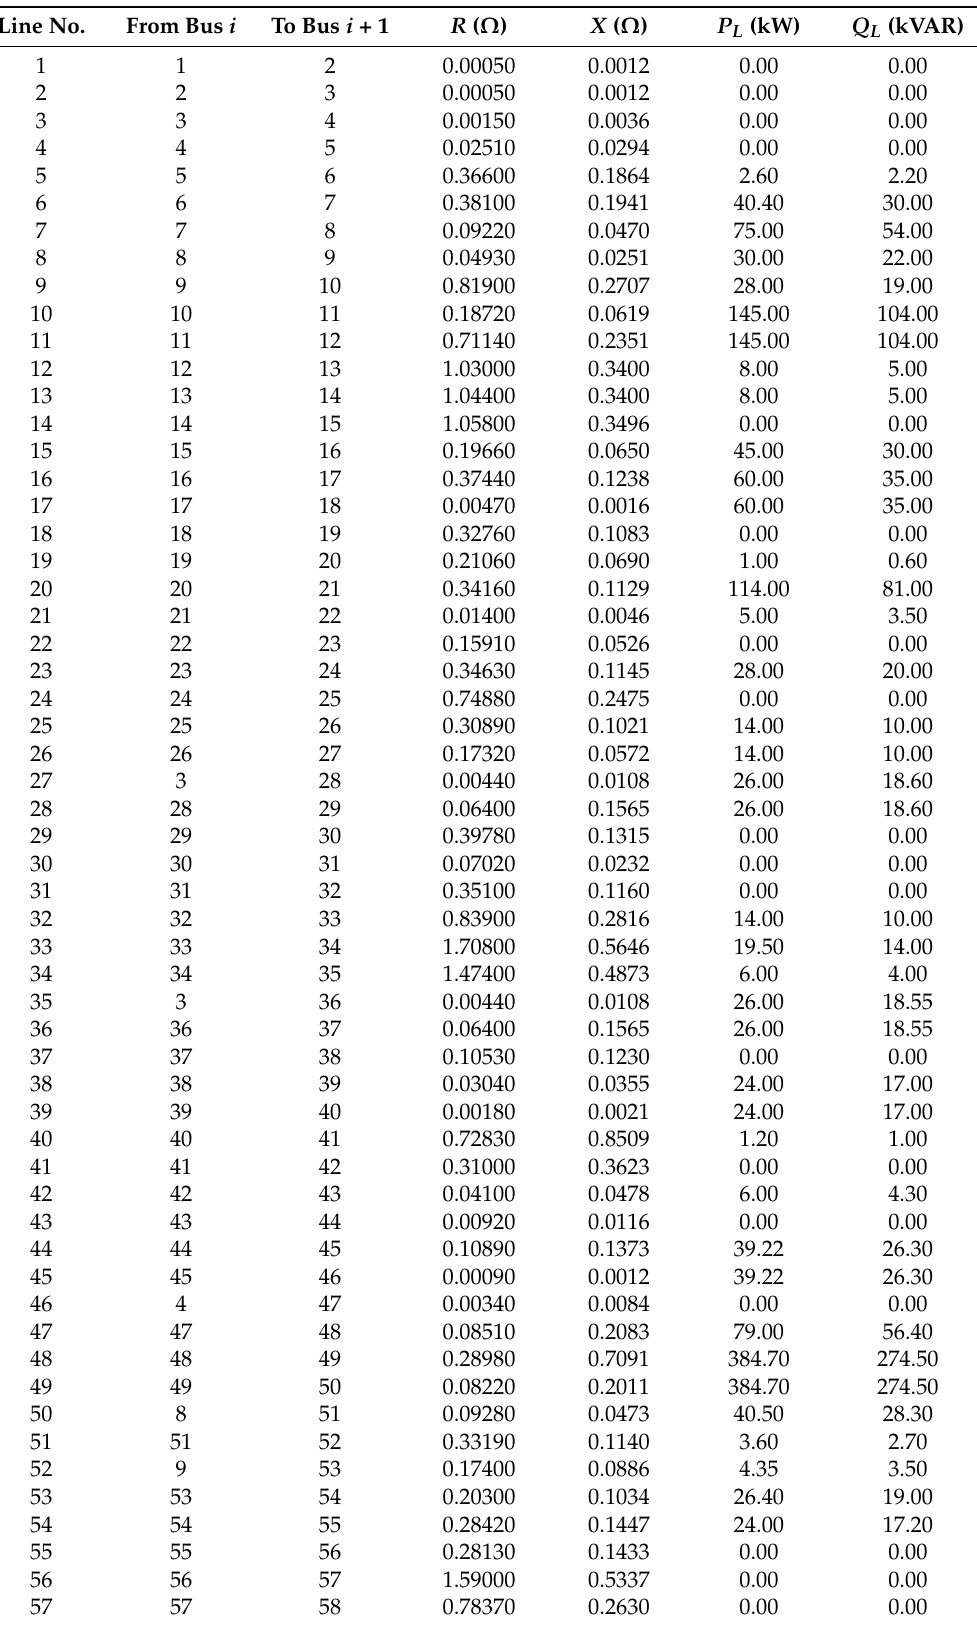
Table A3. 69-bus test system